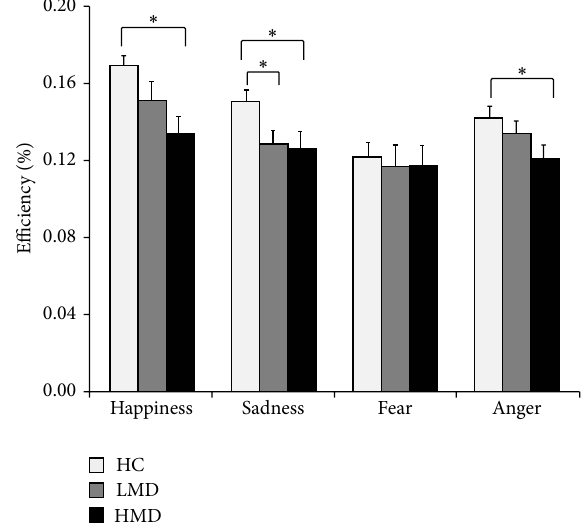
Figure 2: Mean Efficiency scores of the three groups on the Fast Emotion Discrimination Task. HC: healthy controls; LMD: PD patients with low motor dysfunction; HMD: PD patients with high motor dysfunction. Asterisks ( ∗ ) indicate statistical significance at 𝑝 < 0.05